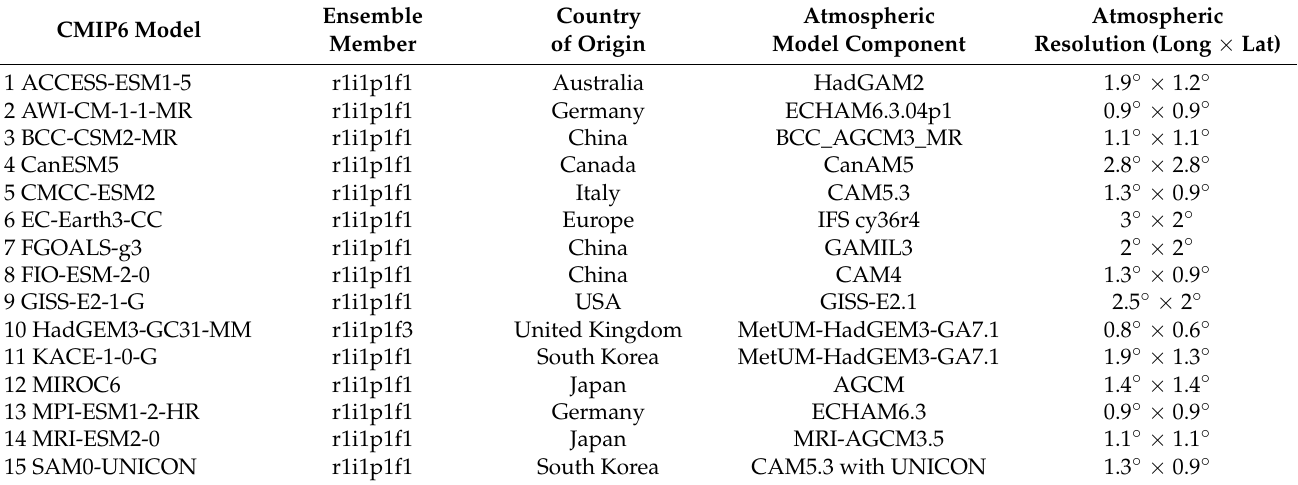
Table 1. List of the CMIP6 models used in this study with country-of-origin information and horizontal